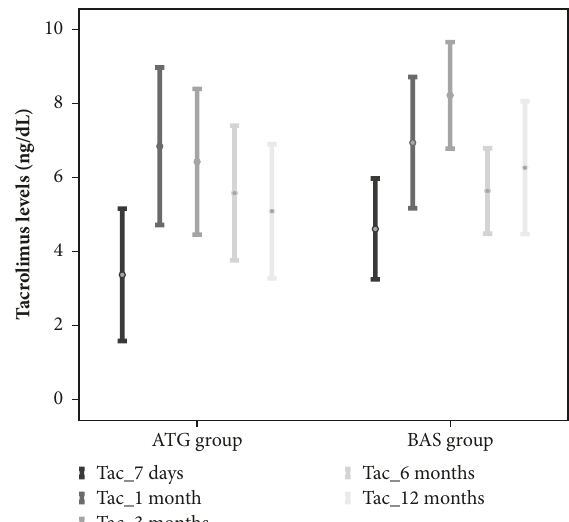
Figure 1: Tacrolimus levels after liver transplantation.